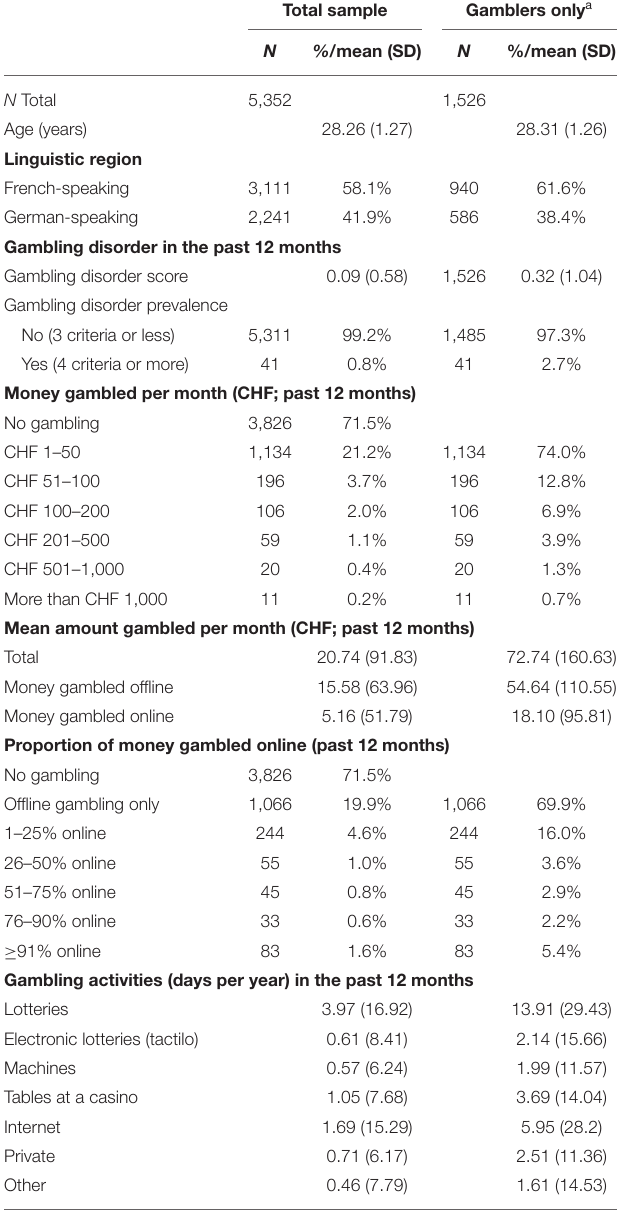
TABLE 1 | Descriptive statistics for the whole